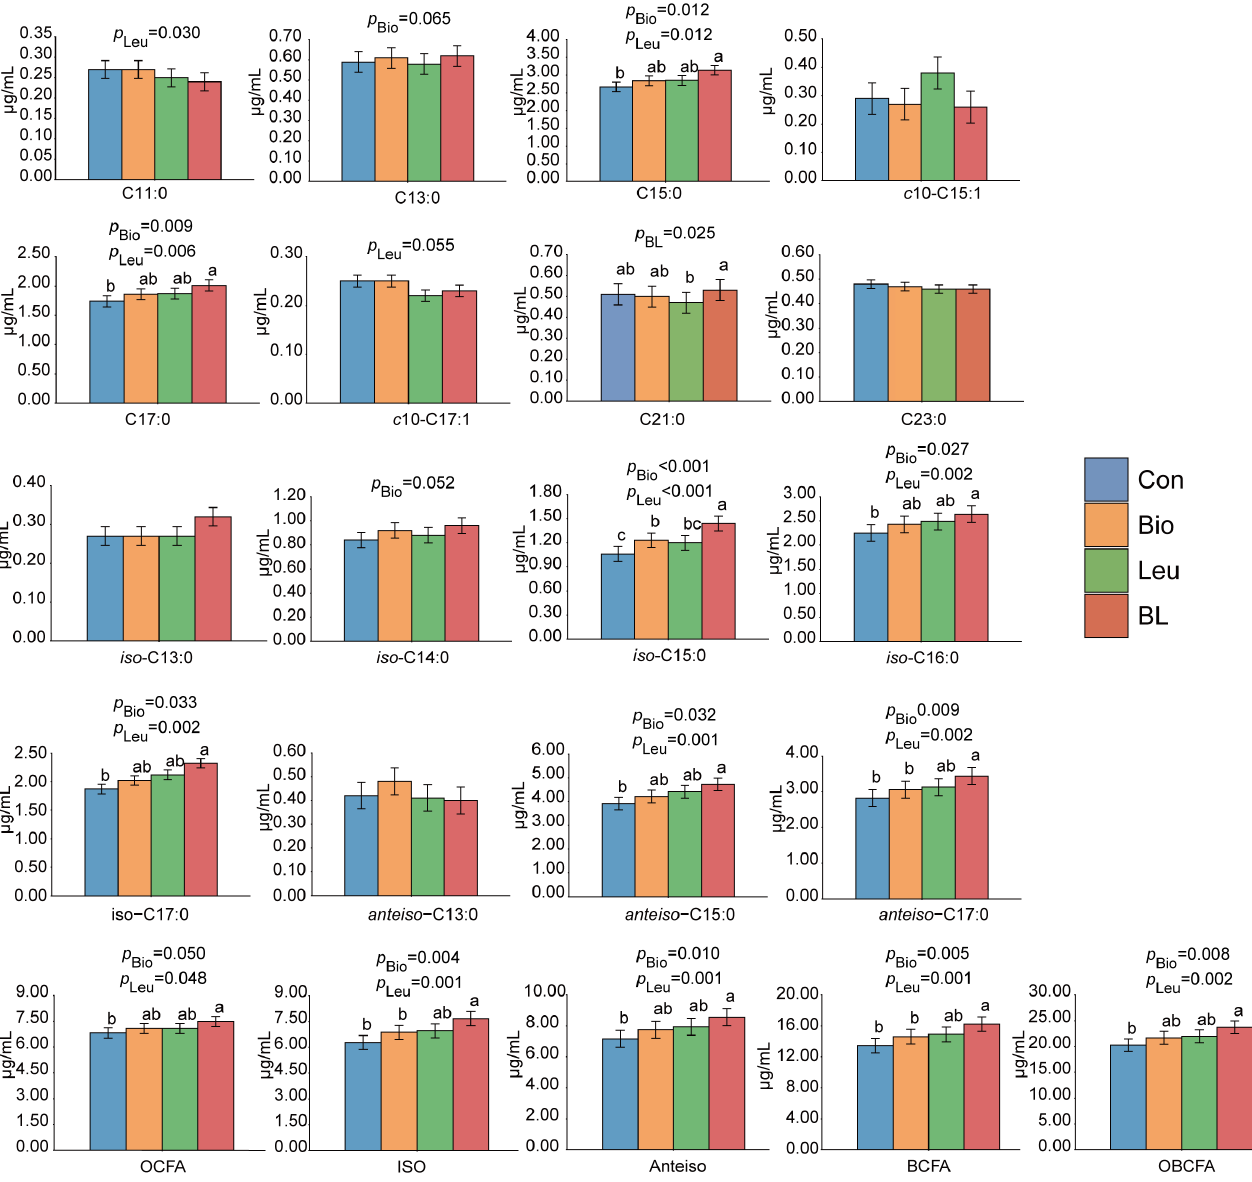
OBCFA = OCFA + BCFA. Columns labeled with different letters are significantly different ( p <